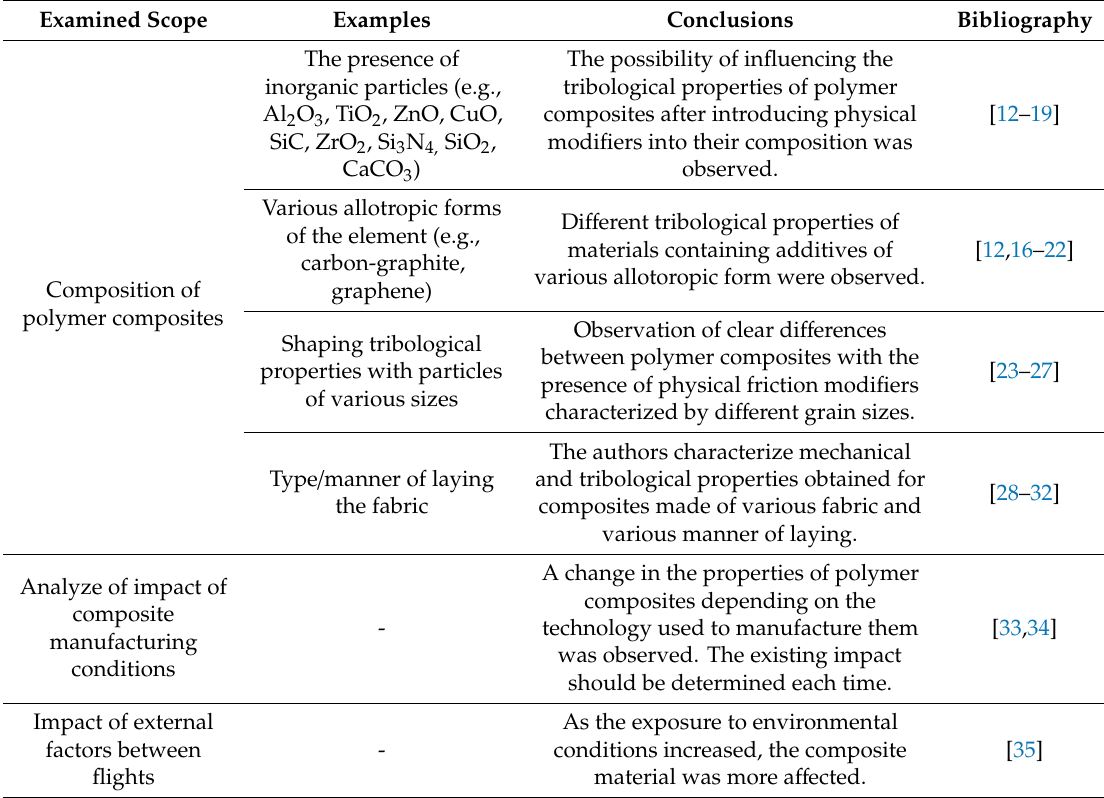
Table 1. Summary of the conducted